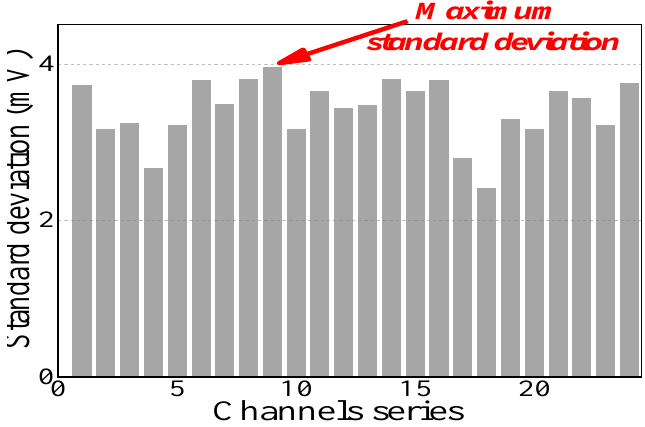
Figure 5. Standard deviation of 24 channels.